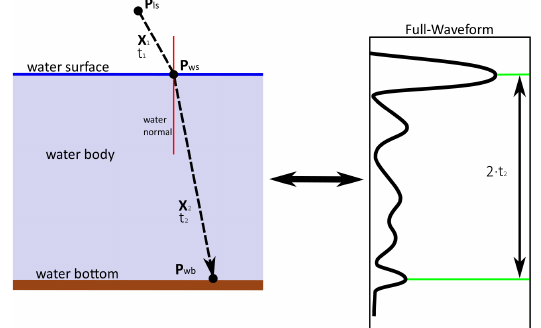
Figure 9. Schematic illustration of water bottom point